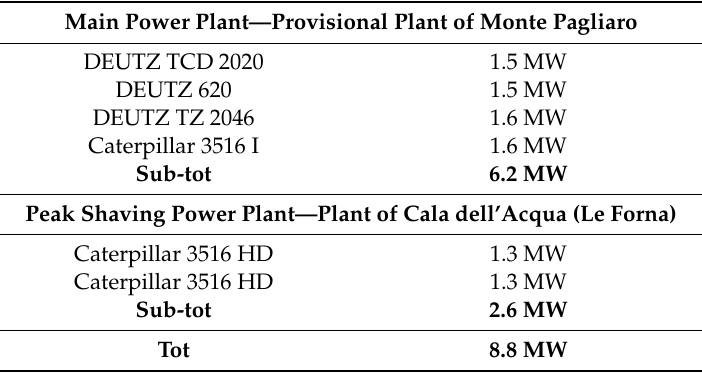
Table 1. Mean climate data values.